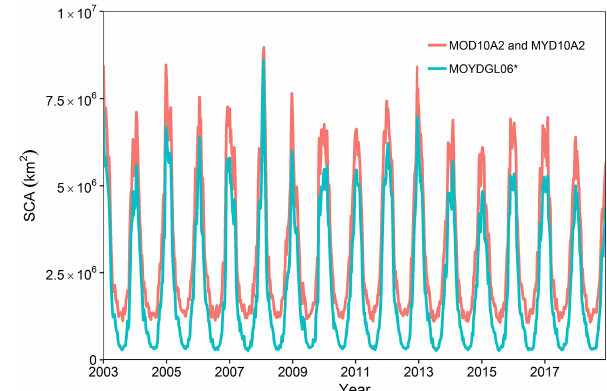
Figure 11. MOD10A2* and MYD10A2* and MOYDGL06* snow cover area (SCA) time series between 2002 and 2018 for the whole study